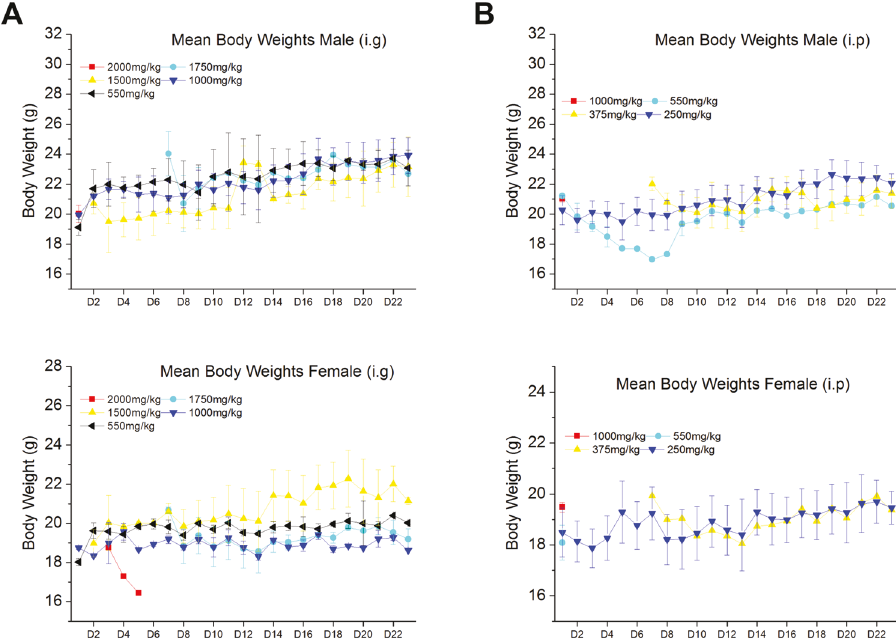
Fig. 4 Body weight after I3C administration in mice. A Body weight after I3C i.g. administration in male ( n = 3; upper graph) and female ( n = 3; lower graph) mice. B Body Weight after I3C i.p. administration in male ( n = 3; upper graph) and female ( n = 3; lower graph) mice. Some group information not included or gradual disappearance in the graph because they died after administration. Data are expressed as mean ±